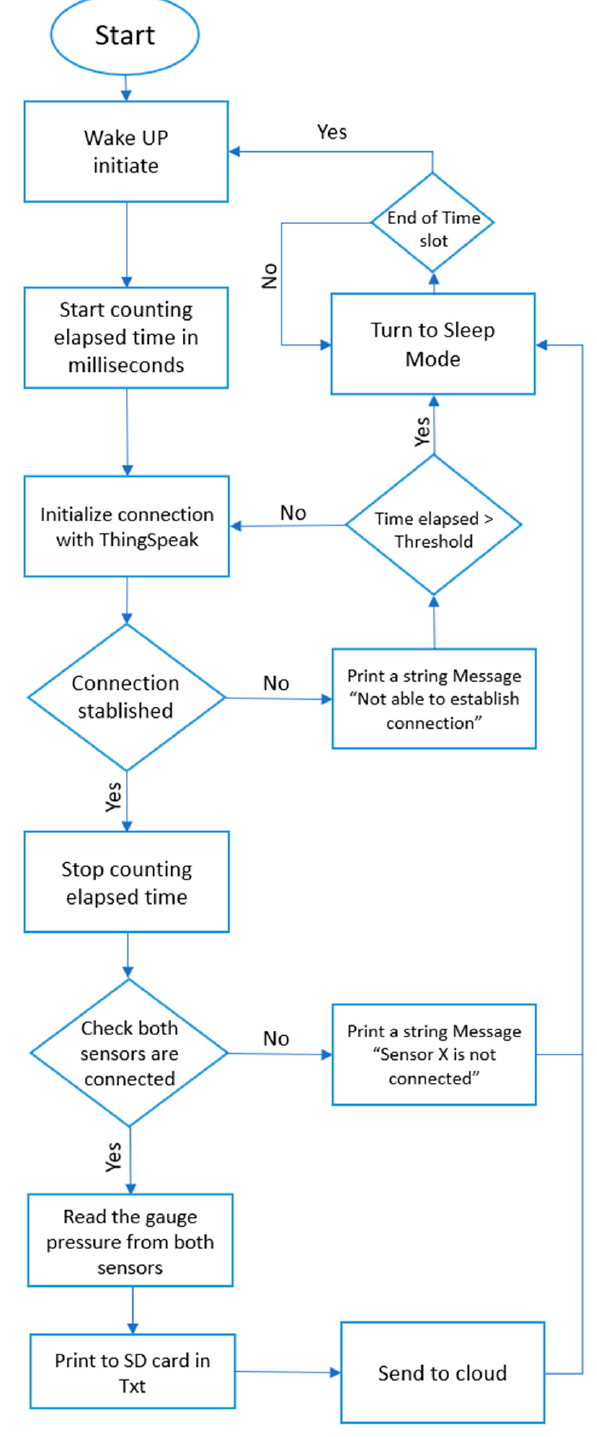
Figure 1. The algorithm flow chart.